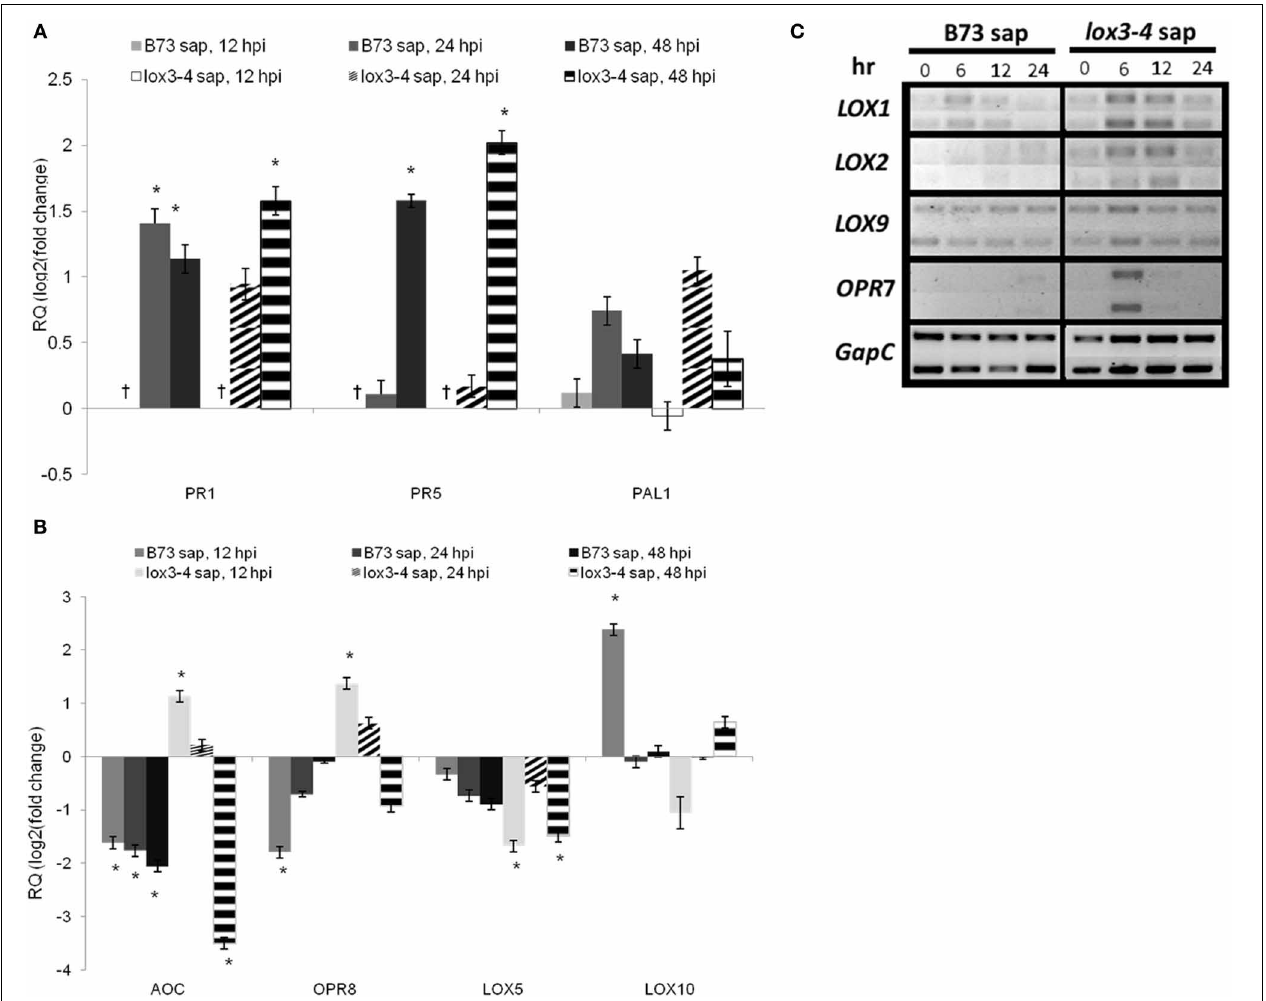
FIGURE 7 | Effect of B73 and lox 3-4 sap on the expression of defense genes in B73 maize inoculated with C. graminicola . (A) relative expression of SAR-related genes PR1 (pathogenesis related 1), PR5 (pathogenesis related 5), and PAL1 (phennyl alanine amonia lyase), (B) relative expression of genes involved in octadecanoid pathway, AOC (allene oxide synthase), OPR8 (12-oxo-phytodienoic acid 8), LOX5, and LOX10 (lipoxygenase 5 and 10, respectively) and (C) semi-Q-RT-PCR analysis of expression of LOX1, LOX2, LOX9, and OPR7. B73 maize plants at V4 stage were treated with xylem sap from B73 or lox3-4 plants (as described in materials and methods) and were inoculated with C. graminicola 3h later.